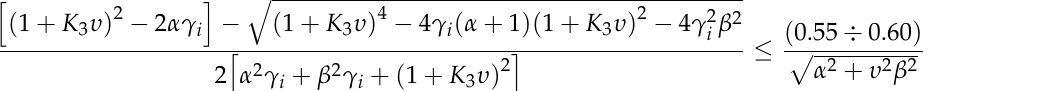
Figure 6. Typical graphs showing the tendency of s and s K vs. increase in frequency. This minimum applicable relative frequency ( υ min ) can be found from the following difference: